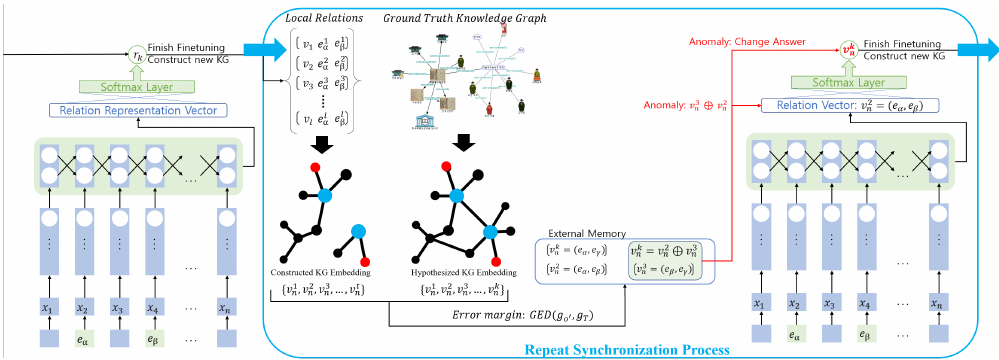
Figure 1. Overall process of GREG: Global level Relation Extraction with knowledge Graph embedding.